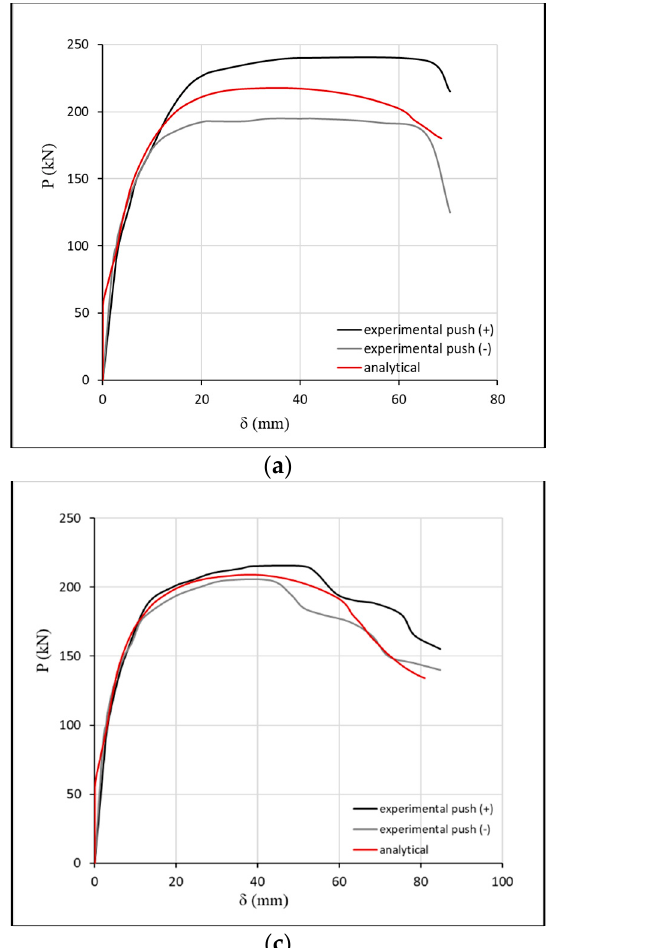
shear force–displacement curve for specimens ( a ) R-P2L0, ( b ) R-P2L1, ( c ) R-P2L3; ( d ) Comparison of the analytical P- δ